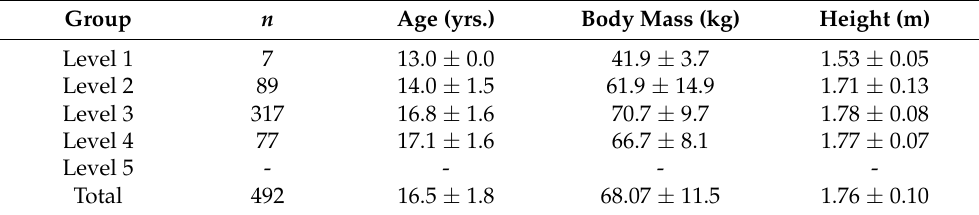
Table 1. Means and standard deviations of age and anthropometric data. Group n Age (yrs.) Body Mass (kg) Height (m) Level 1 7 13.0 ±